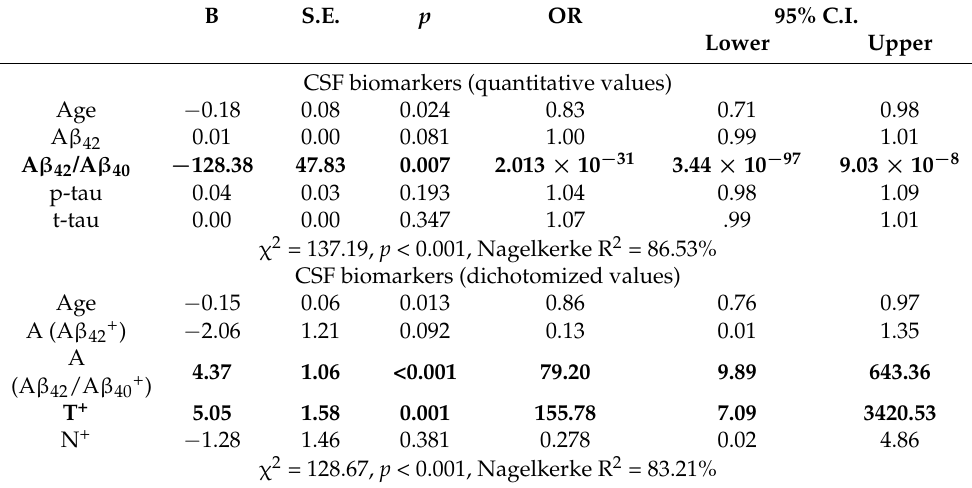
Table 3. Multivariate logistic regression models.